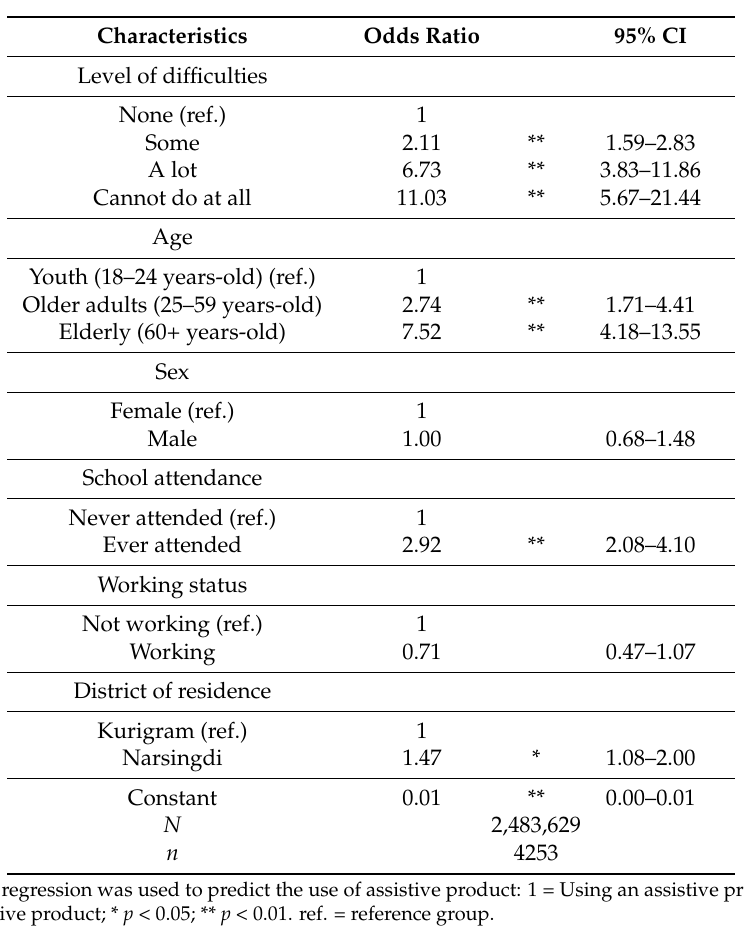
Table 2. Factors associated with the use of assistive products.